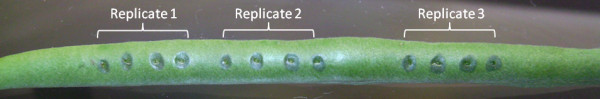
Assessment of pathogenicity of mutant strains in Phaseolus vulgaris. Three replicates are indicated each containing, in order from left to right, WT, pvd-, acr/pvd- and acr-/pvd-/ybt- strains. Each strain was inoculated from a single colony, using a hypodermic needle. The pod was then incubated in a humid chamber at room temperature for 48 hours. All strains display characteristic water-soaked lesions indicating successful establishment of pathogenicity in Phaseolus vulgaris.